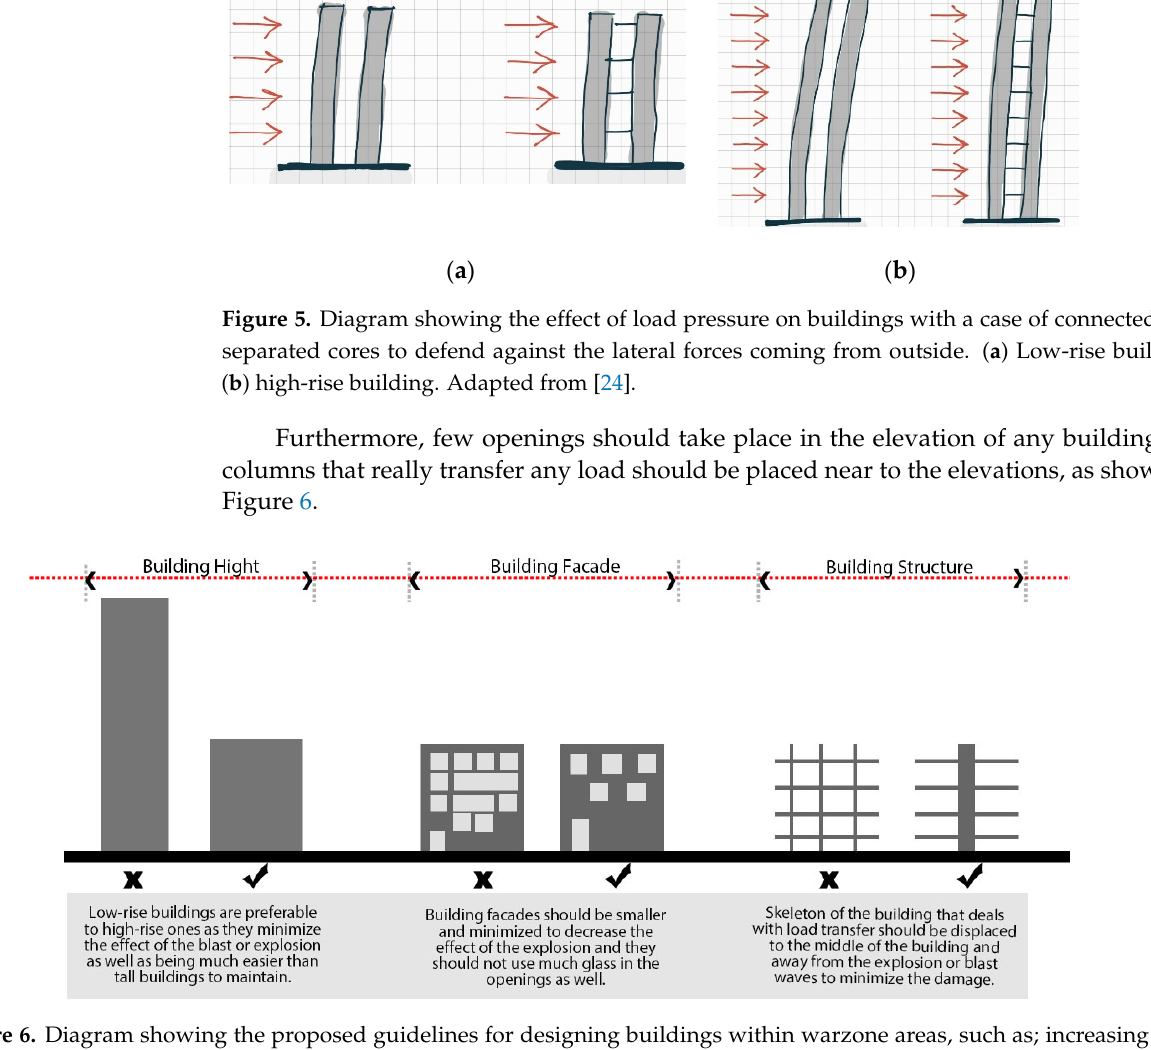
Figure 6. Diagram showing the proposed guidelines for designing buildings within warzone areas, such as; increasing the use of low-rise buildings instead of high-rise buildings, decreasing the number of facade openings for minimizing and resisting the possible destruction effects. Source: (Y.M.).